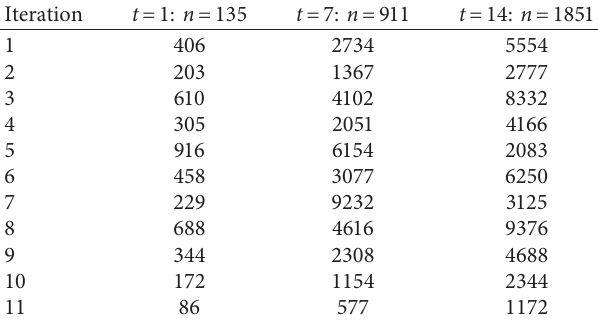
Table 2: Theorem 3 (iv) examples.